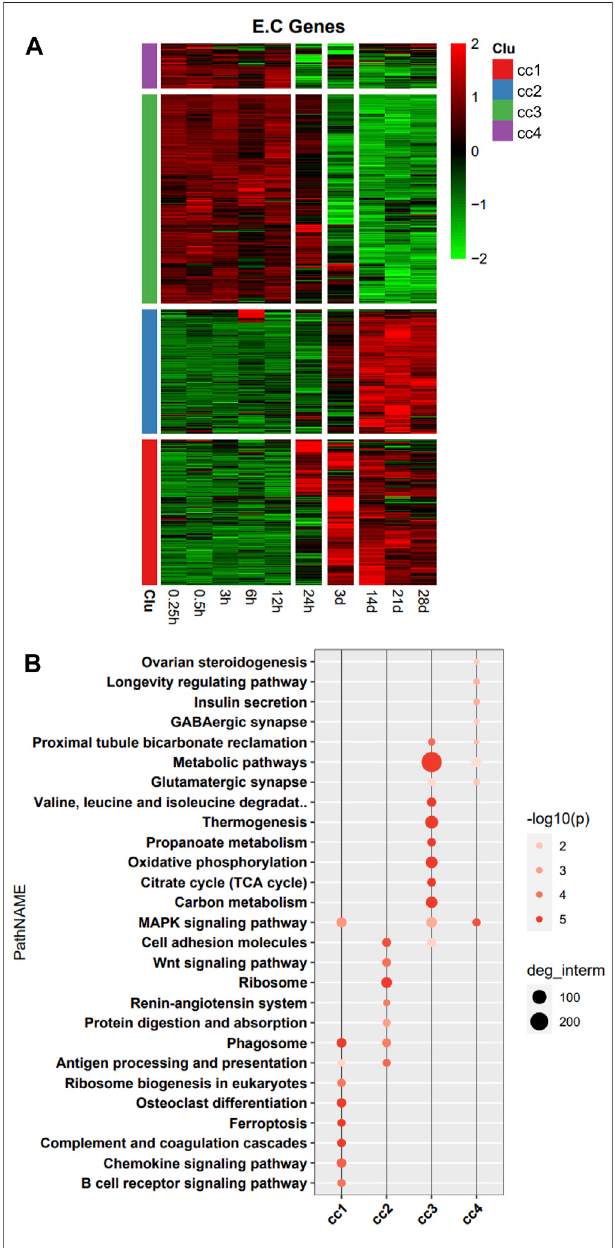
FIGURE 2 | Heatmap and functional analysis of all differentially expressed genes (DEGs). (A) DEG expression patterns. (B) Functional enrichment